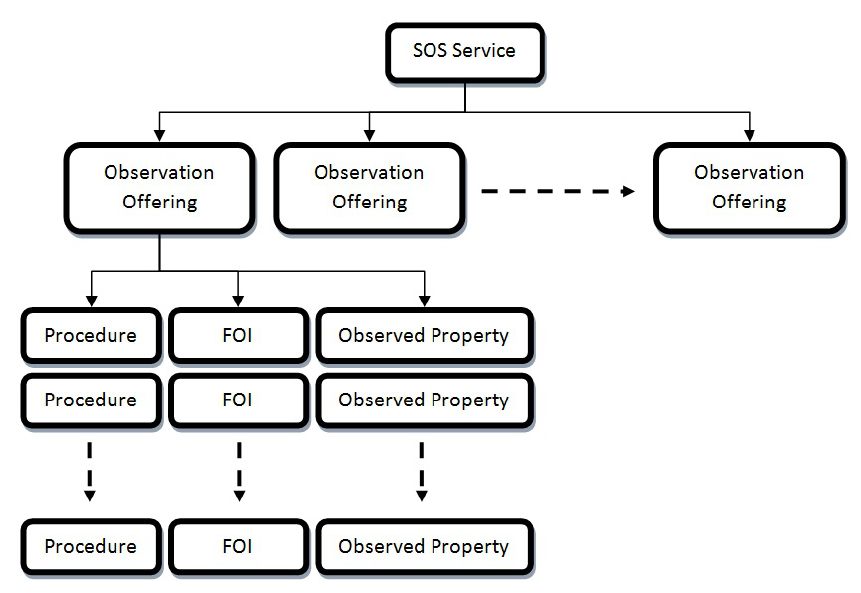
Figure 1. SOS structure overview.